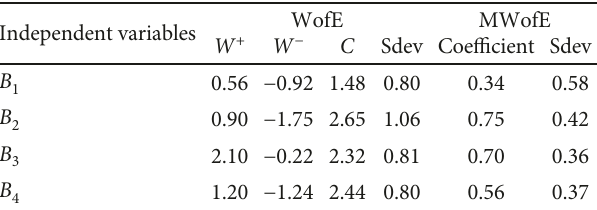
Table 6: Comparison of WofE weights and contrasts with MWofE coe ffi cients and their standard deviations (Sdev) in experiment